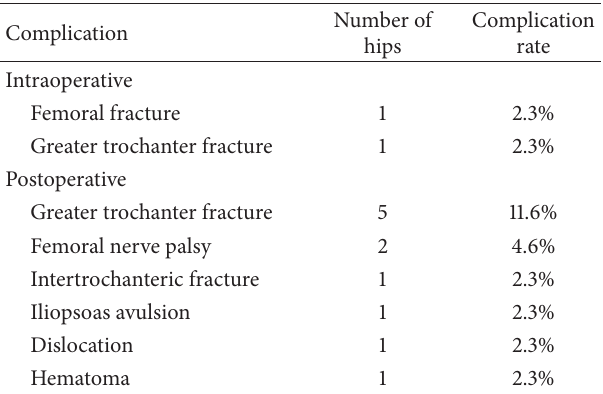
Table 2: Intraoperative and postoperative complications following anterior approach total hip arthroplasty.